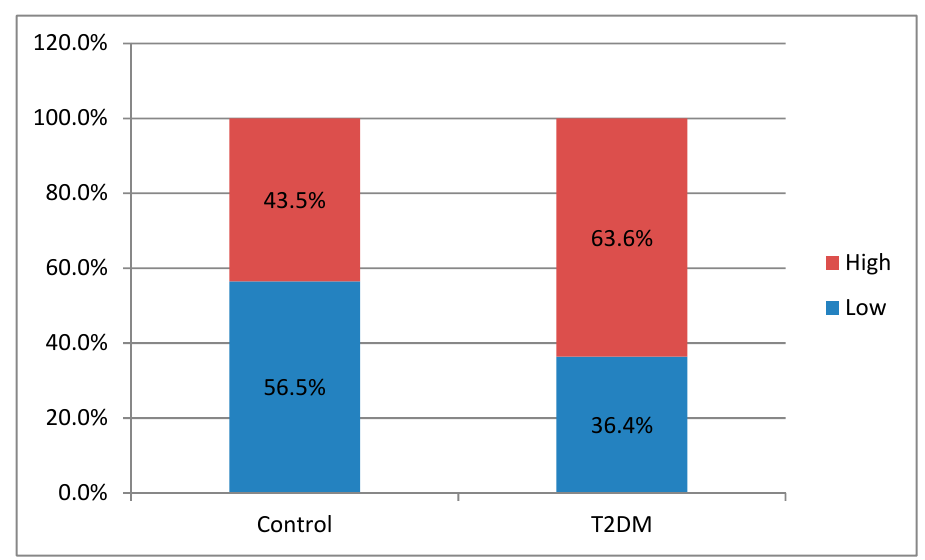
Figure 1. Pro-inflammatory potential differences.